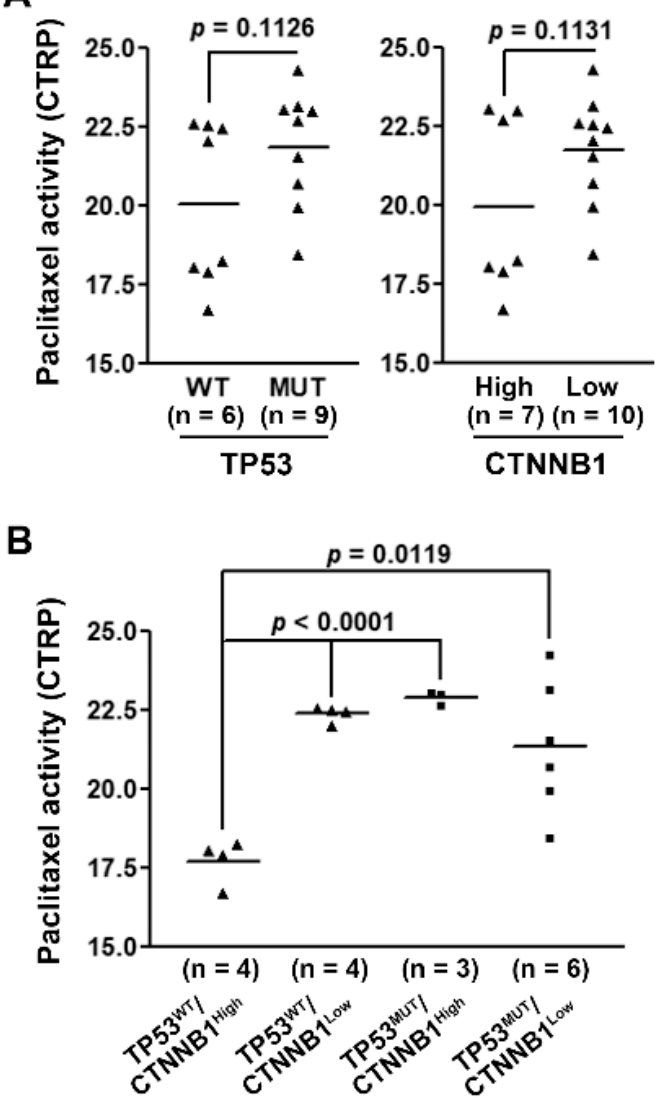
Figure 5. The role of TP53 and CTNNB1 gene statuses in the paclitaxel drug sensitivity in hepatocellular carcinoma cells. The paclitaxel drug activity in HCC cell lines according to the TP53 mutation status ( A , left), CTNNB1 mRNA expression ( A , right), or their combination ( B ).